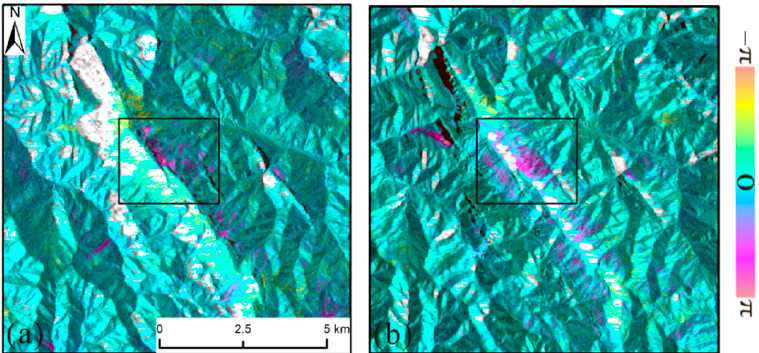
Figure 3. Example of D-InSAR results. Black boxes in ( a ) ascending and ( b ) descending maps indicate the noise phase caused by glacier movement and snowmelt.